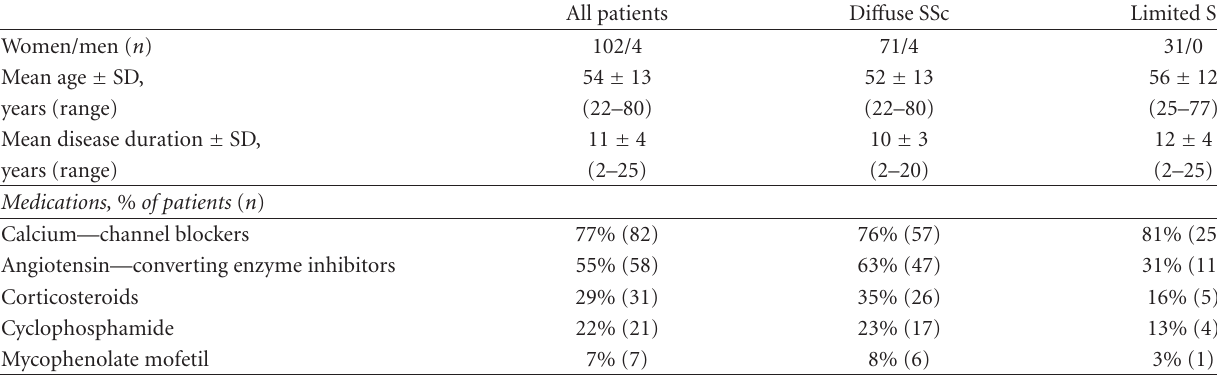
Table 1: Characteristics of patients with systemic sclerosis (SSc).